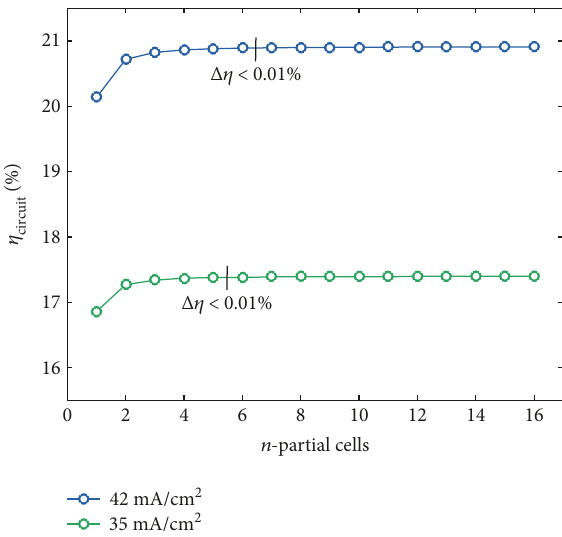
Figure 5: Re fl ection of the backsheet via Lambertian re fl ection I (blue) and re fl ection on the glass I FR via Fresnel equation (green).